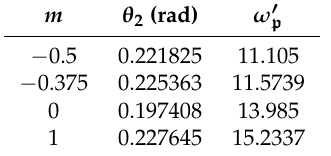
m θ 2 (rad) ω (cid:48) p − 0.5